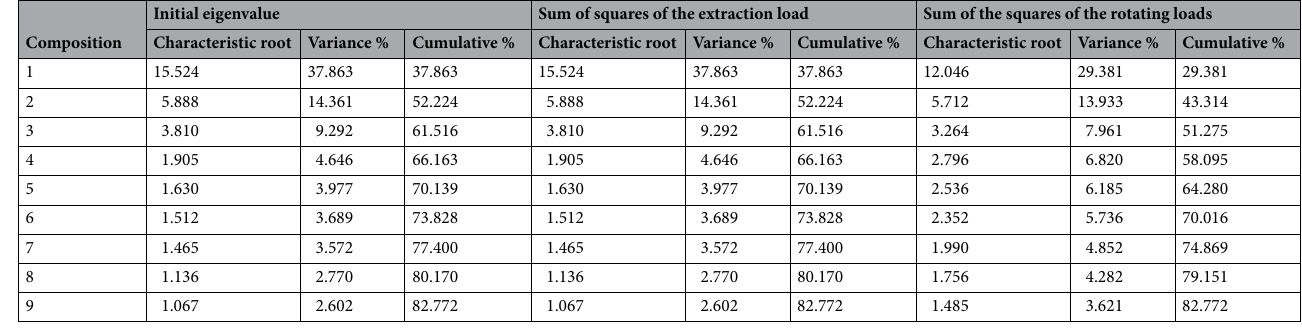
Table 2. Total variance